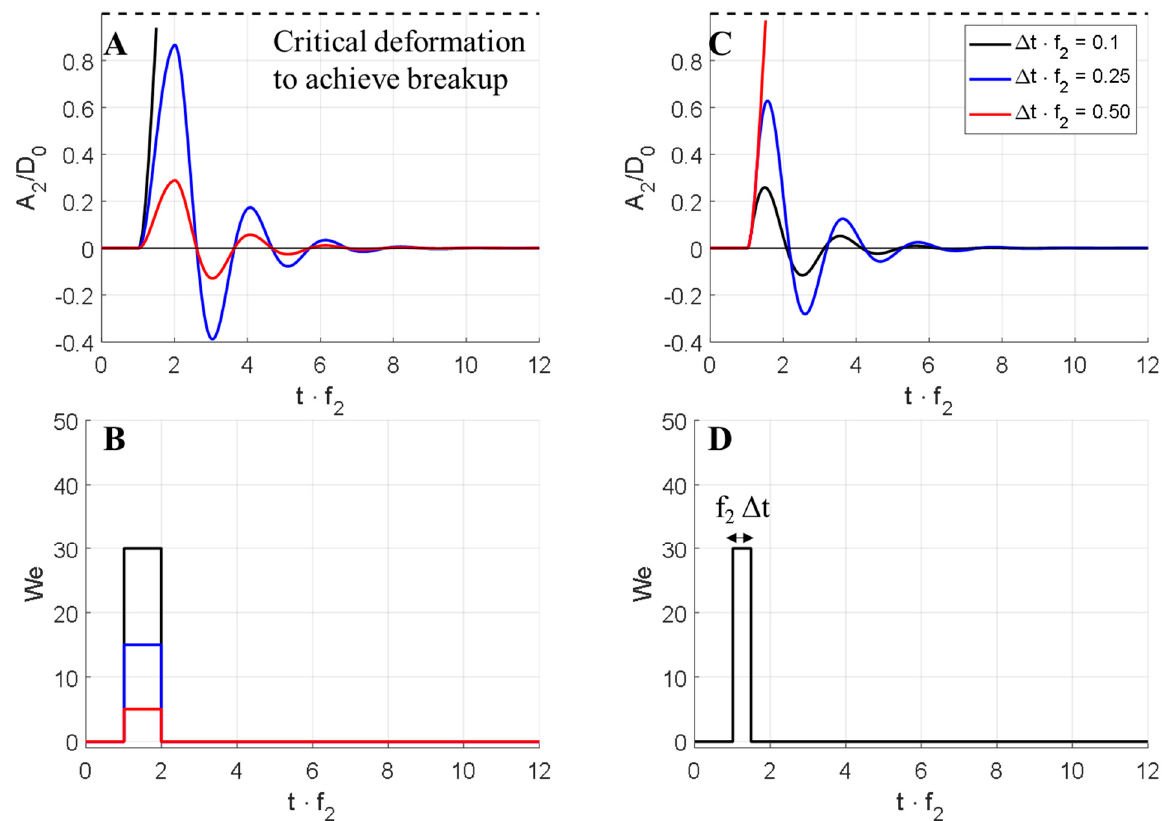
Figure 11. Illustration of the Rayleigh–Lamb model (Equation (35)), showing how the drop amplitude behaves when encountering a single high-We pulse with a duration ∆ t . The drop is predicted to break once the deformation reaches A 2 / D 0 = 1 (i.e., when extended to a length equal to twice the initial diameter); ( A , B ) compare three cases where the drop is subjected to a fixed width pulse ( f 2 ∆ t = 1) with different intensities (We = 30, black; We = 15, blue and We = 5, red); ( C , D ) compare three cases with constant pulse intensity (We = 30) but different pulse widths ( f 2 ∆ t = 0.1, black; f 2 ∆ t = 0.25, blue and f 2 Δ t = 0.5, red). ( D 0 = 50 μ m, ρ C = ρ D =10 3 kg/m 3 , μ C = μ D = 1 mPa s, γ = 20 mN/m and K = 1/25.)